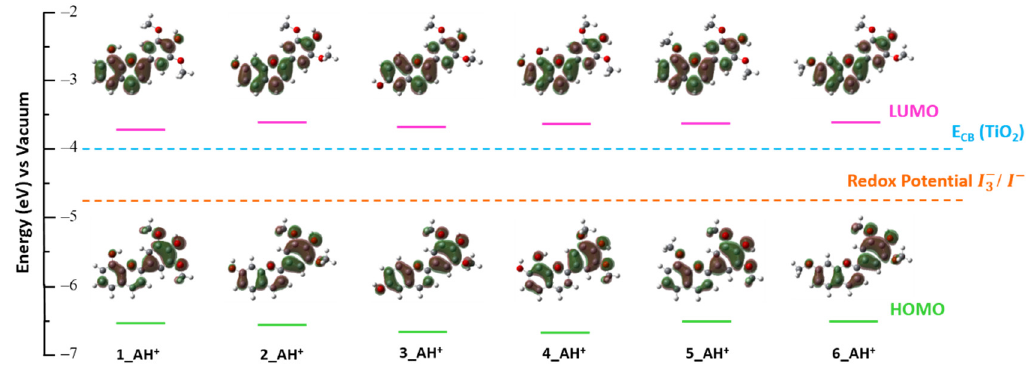
Figure 5. Energy level diagram for the dyes (flavylium cations AH + ).